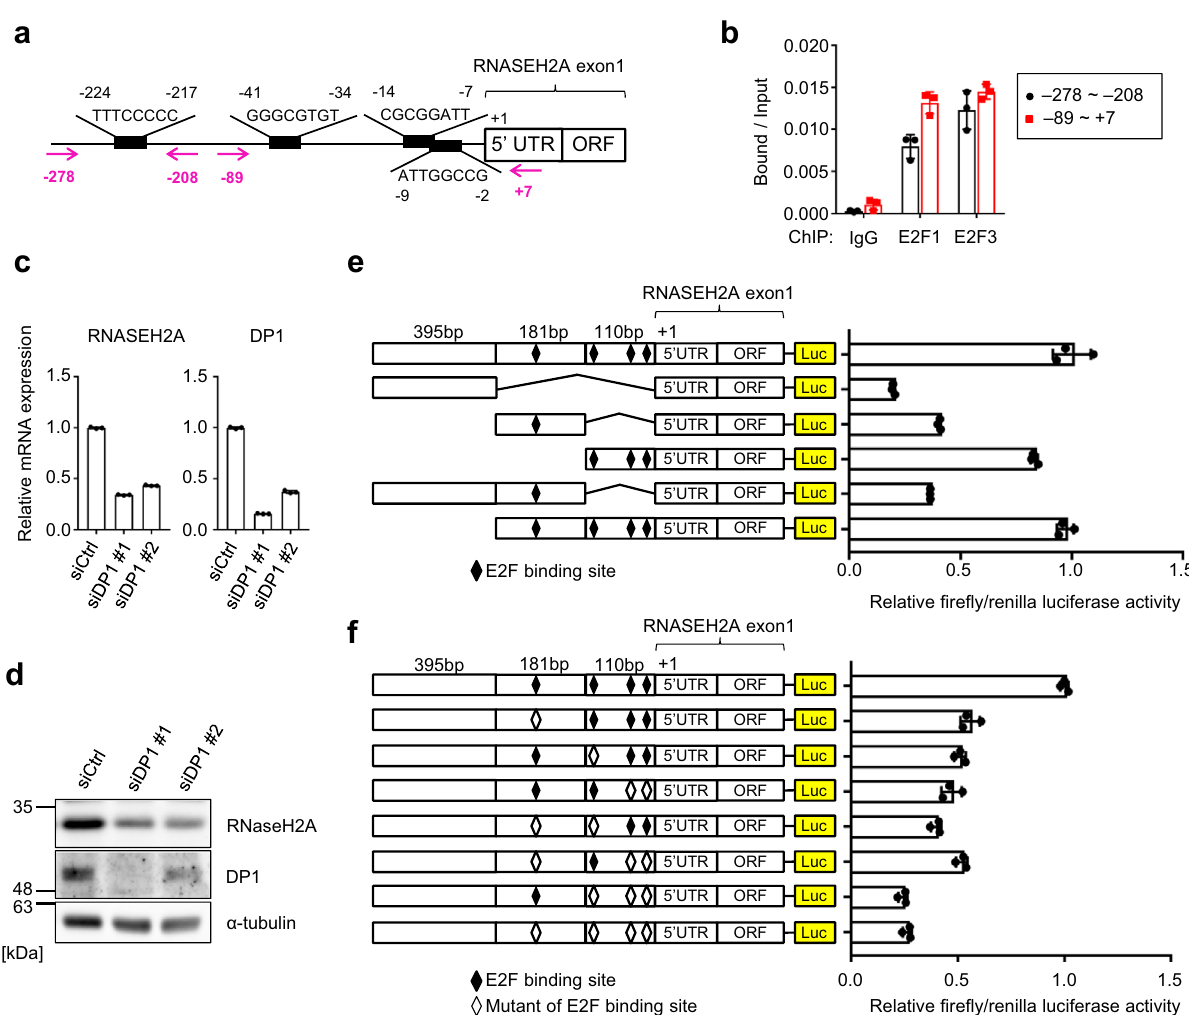
activityE2F binding site Relative firefly/renilla luciferase Mutant of E2F binding site Fig. 2 RNaseH2A is regulated by E2F transcription factors. a Schematic diagram showing the E2F-binding sites in the RNaseH2A gene promoter. Red arrows indicate the region containing the PCR primers for ChIP analysis. b ChIP-qPCR analysis of pre-senescent TIG-3 cells using antibodies shown at the bottom. Error bars indicate the mean ± SD of technical triplicates. c RT-qPCR analysis of RNASEH2A and DP1 mRNA expression with siRNA-treated TIG-3 cells. Error bars indicate the mean ± SD of technical triplicates. d Western blot of TIG-3 cells as in c using antibodies shown at right. Alpha-tubulin was used as a loading control. e Left panel: Schematic representation of the reporter construct of human RNASEH2A gene promoter used in the analysis. Fire fl y luciferase is shown as Luc. Right panel: HEK293T cells were transfected with the indicated reporter plasmids and a Renilla plasmid as an internal control. After 48 h of transfection, luciferase activities were measured. Error bars indicate the mean ± SD of technical triplicates. f Left panel: Schematic representation of the reporter construct of human RNASEH2A gene promoter used in the analysis. The E2F-binding element or its mutant is presented as a black or white rhombus. The fi re fl y luciferase is shown as Luc. Right panel: HEK293T cells were transfected with the indicated reporter plasmids and a Renilla plasmid as an internal control. After 48 h of transfection, luciferase activities were measured. Error bars indicate the mean ± SD of technical triplicates. All data were representative of at least three biological